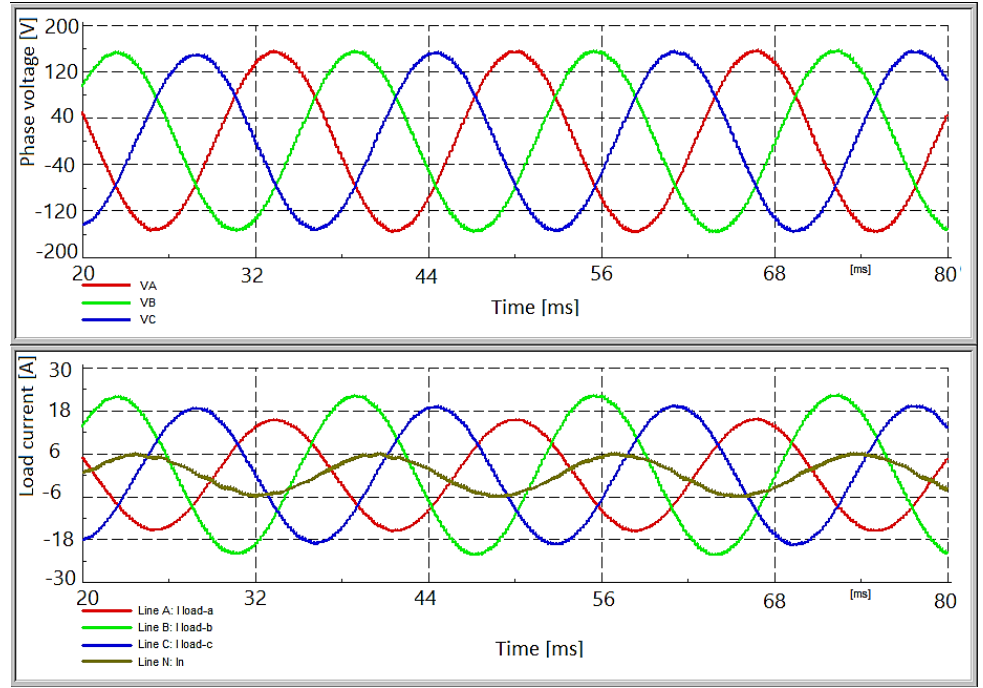
Figure 15. Output three-phase voltages and currents for Unb.#1.